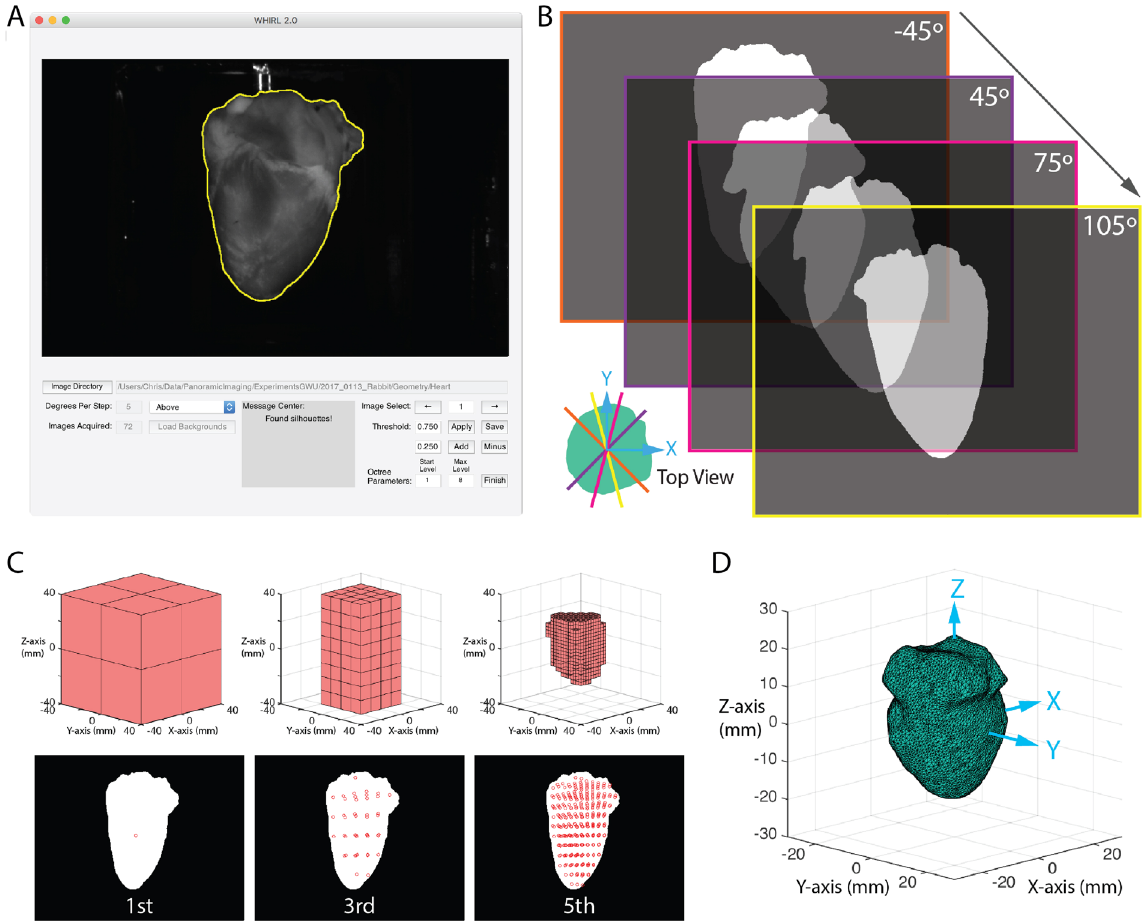
Figure 3. Geometric reconstruction. ( A ) A MATLAB graphical user interface was developed to facilitate accurate identification of the heart silhouettes needed for geometric reconstruction. A detailed description and the code are included in the toolkit. ( B ) The heart was rotated, and binary silhouette images were collected every 5 degrees. ( C ) Using the occluding contours method paired with an octree algorithm a series of voxels are iteratively broken down to identify the heart volume. ( D ) The surface mesh is generated by MATLAB from this volume and smoothed by external C